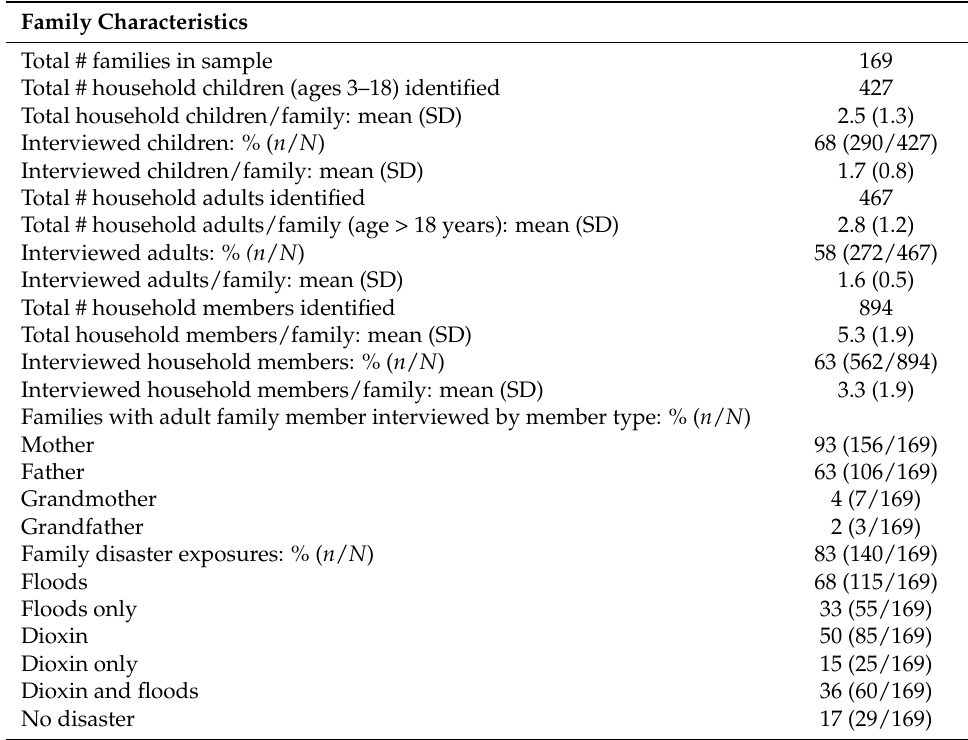
Table 1. Sample description and